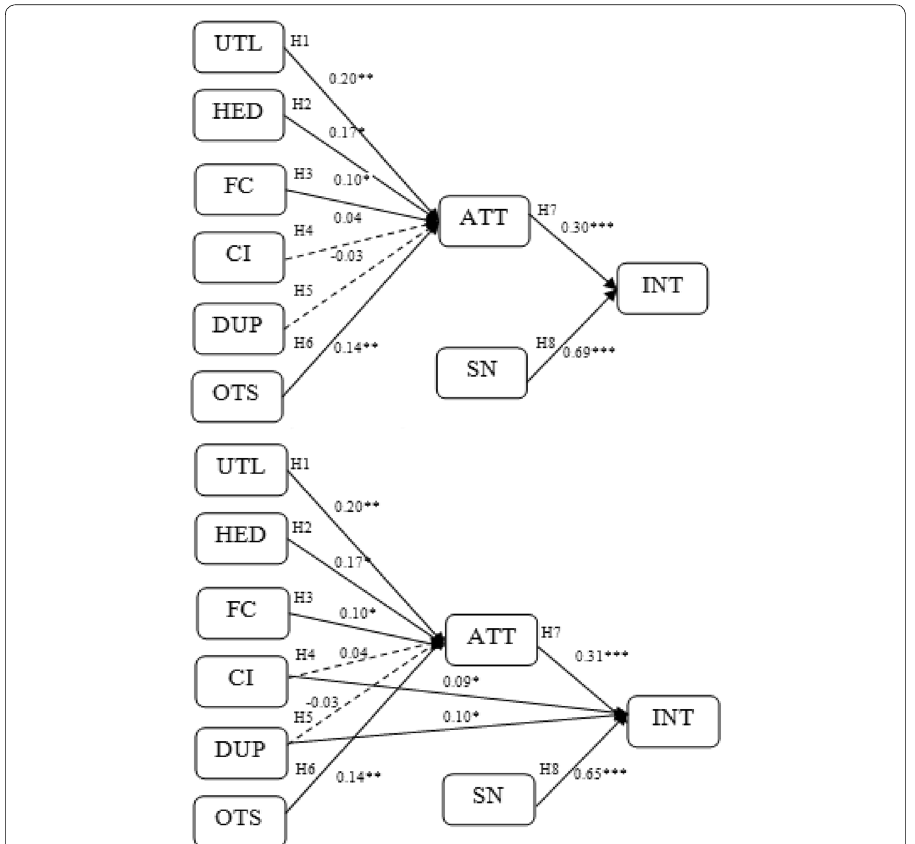
Fig. 3 The results of the theoretical (left) and revised (right) models with path coefficients. UTL Utilitarian motivations, HED Hedonic motivations, FC fashion consciousness, CI consumer innovativeness, DUP desire for unique products, OTS online transaction self-efficacy, ATT attitude towards fashion/beauty SOS, SN subjec- tive norm, INT intention to use fashion/beauty SOS. Theoretical model: χ 2 (6) CFI